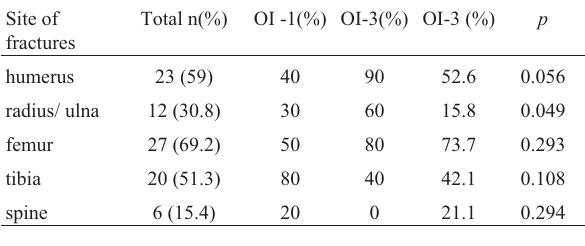
Table 2 - Number and site of fractures according to OI type.